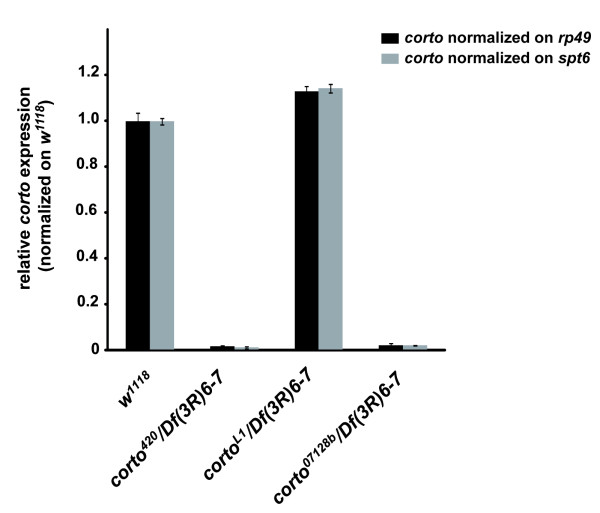
Quantification of corto transcripts by quantitative RT-PCR on wing discs from corto420/Df(3R)6-7, cortoL1/Df(3R)6-7 and corto07128b/Df(3R)6-7 third instar larvae. The relative corto expression level was obtained by normalization on rp49 (black bars) or spt6 (grey bars) level. For each mutant genotype, this normalized level was compared to that of wild type (w1118) wing discs.